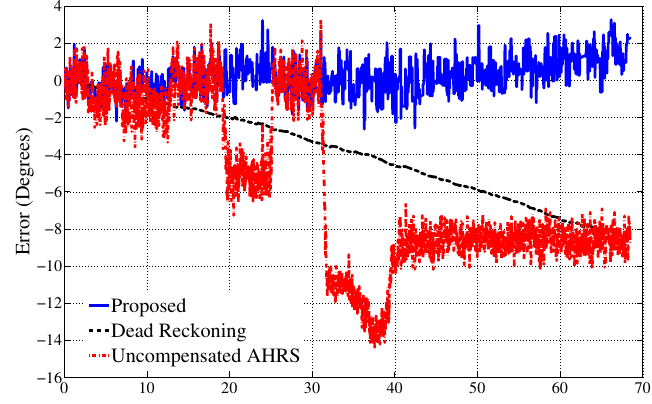
Figure 12. Accuracy of the proposed algorithm in the static